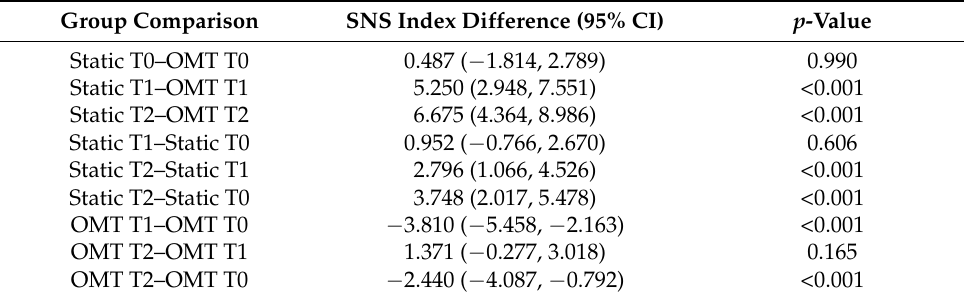
Table 6. Tukey post hoc tests regarding SNS